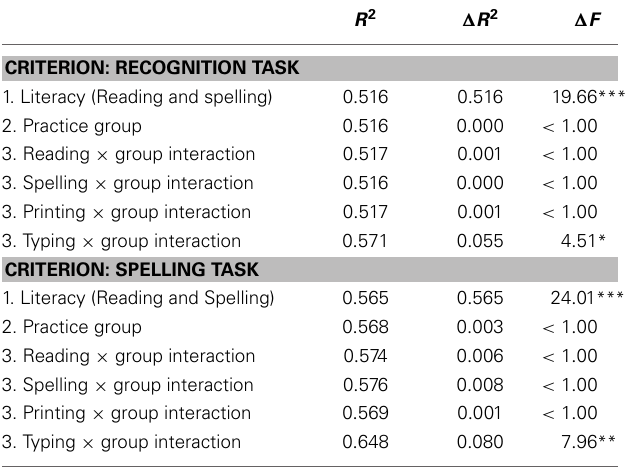
Table 4 | Regression analysis predicting performance on multiple-choice and spelling